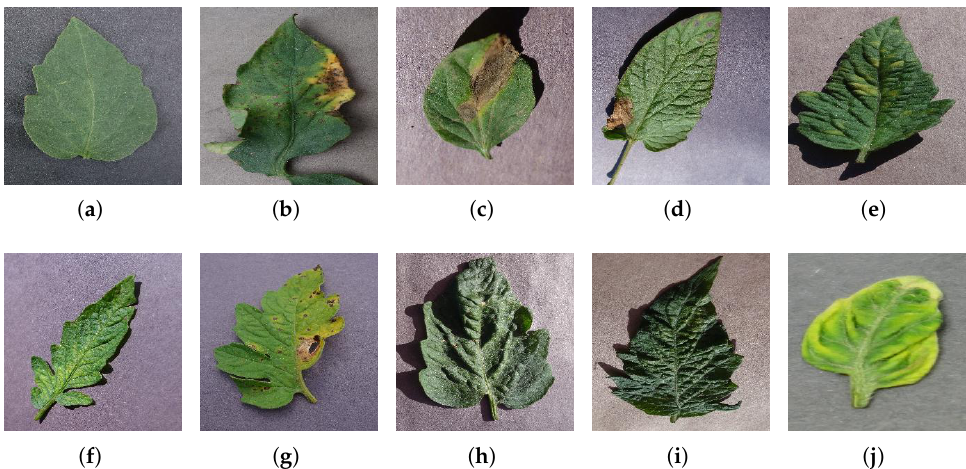
Figure 1. Distinct sample images from the dataset for individual diseases. ( a – j ) denote “healthy”, “bacterial spot” , “early blight”, "late blight", “leaf mold”, “mosaic virus”, “Septoria leaf spot”, “target spot”, “two spotted spider mite”, and ”yellow leaf curl virus” classes, respectively.